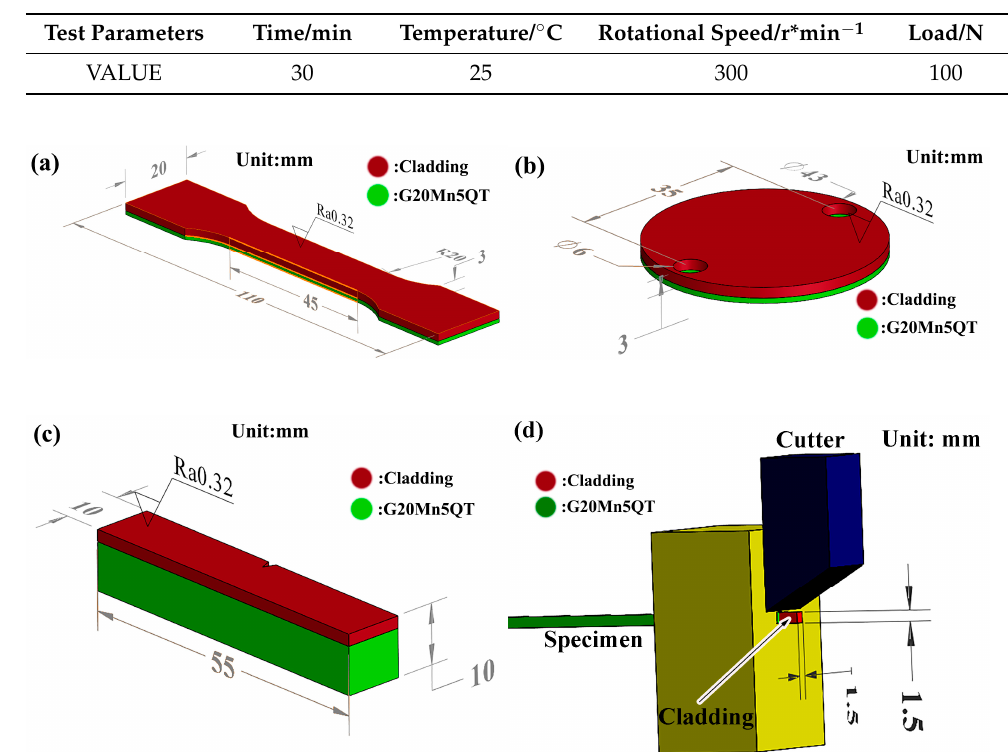
Figure 3. Schematic diagram of test sample for mechanical properties: ( a ) tensile; ( b ) frictional and wear ( c ) impact; ( d ) micro-shear. Table 5. Friction and wear test